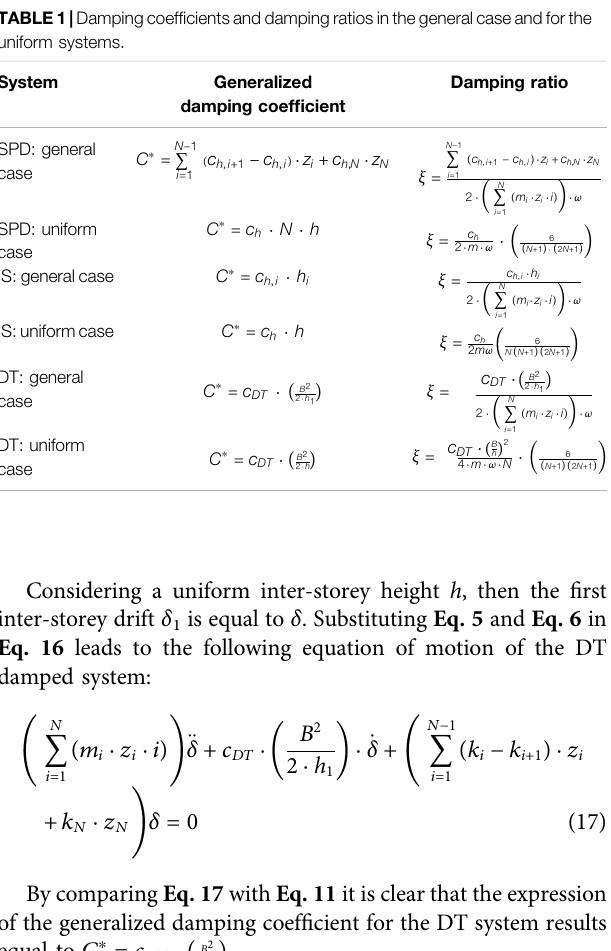
TABLE1| Dampingcoef fi cientsanddampingratiosinthegeneralcaseandforthe uniform systems. System Generalized damping coef fi cient